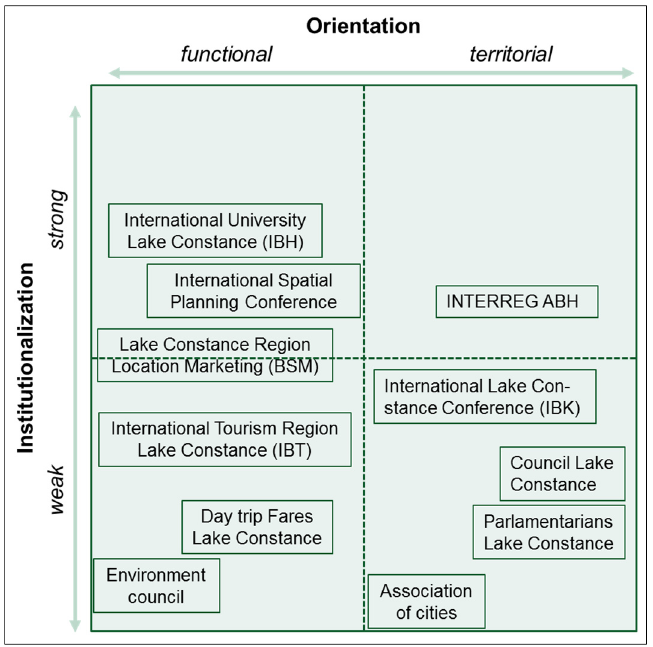
Figure 3. Cross-border organizations in the Lake Constance Region. Source: Authors’ own